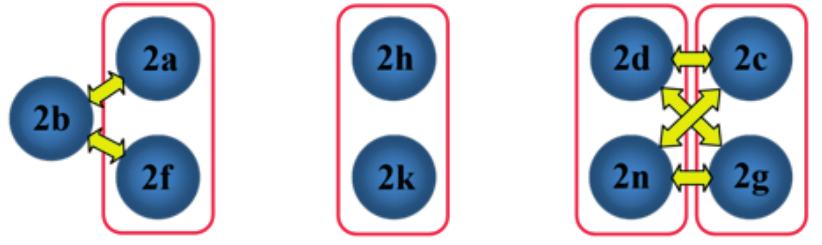
Figure 7. Crystal packing relationship in some studied compounds. Red boxes and yellow arrows indicate 3D and 2D similarities,